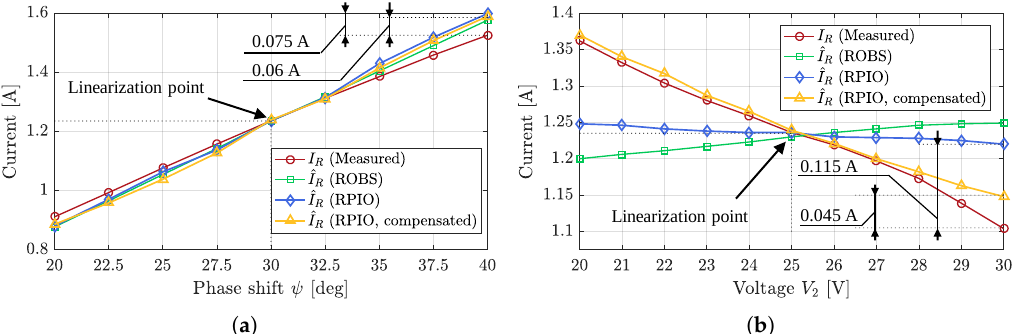
Figure 11. Static performance of the proposed observer. ( a ) ψ = 20 ∼ 40 deg; V 2 = 25 V; ( b ) V 2 = 20 ∼ 30 V; ψ = 30